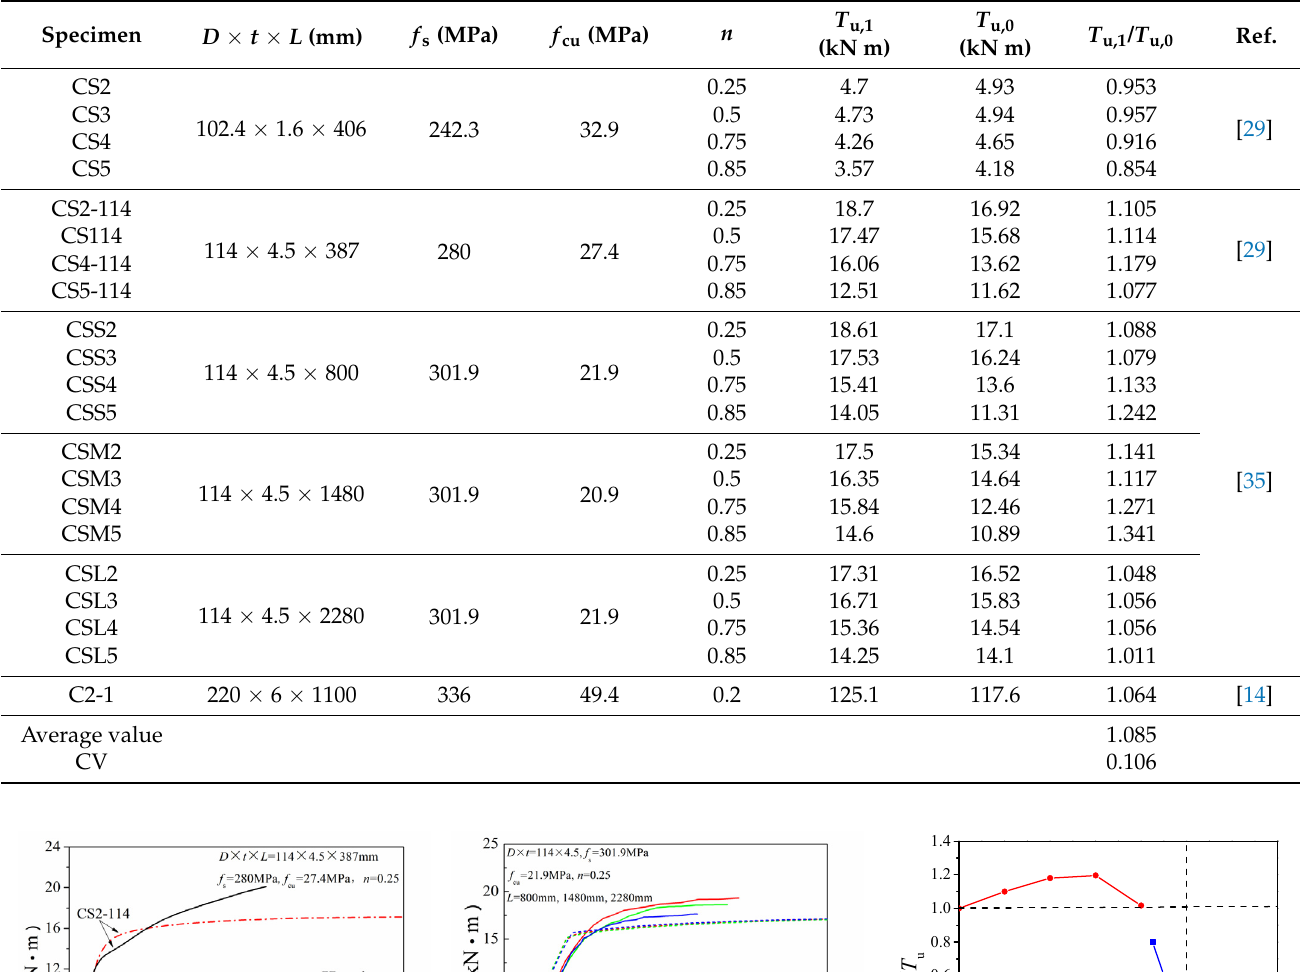
Table 1. Comparison between the test and FE results.